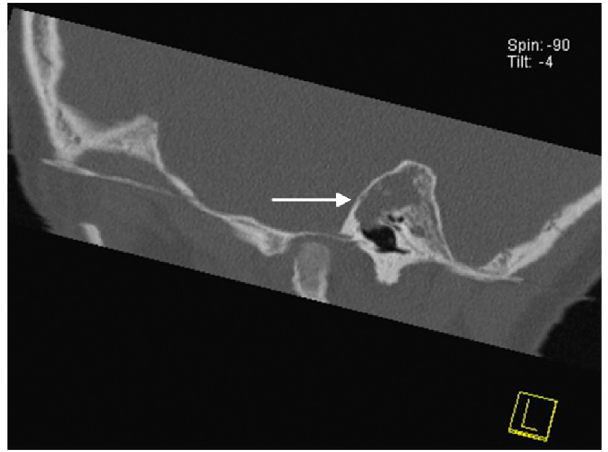
Sagittal scan of the left temporal bone showing the soft tissue mass in the attic and aerated mesotympanum.